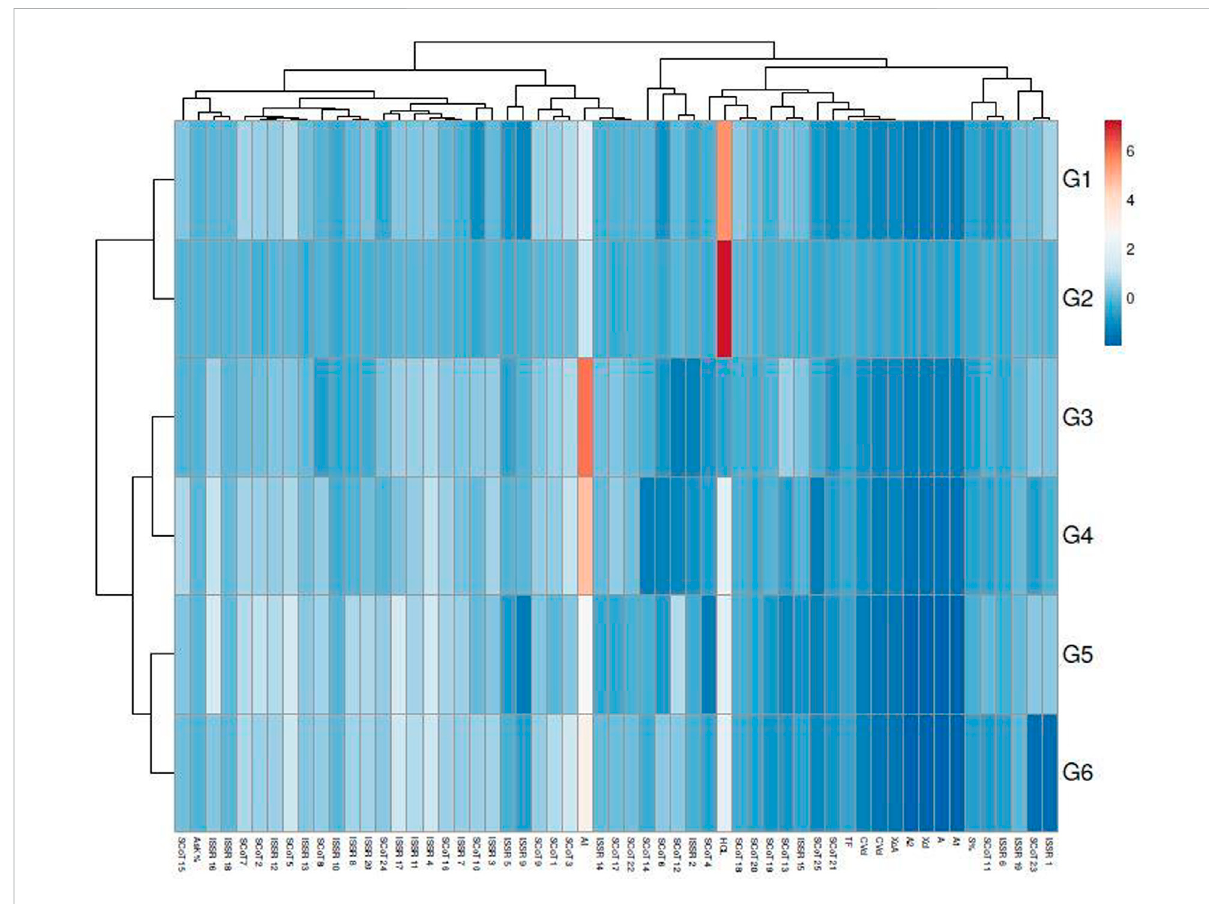
FIGURE 9 Cluster tree for the studied six sesame genotypes based on all molecular markers and cytological parameters. (G1) Ahs-670, (G2) As-1236, (G3) Bah-697, (G4) Jiz-511, (G5) Jiz-517 and (G6)